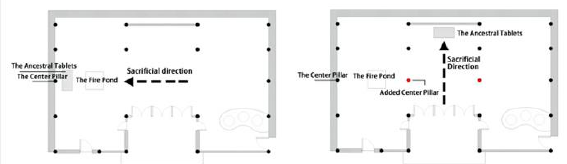
Figure 15. Impact of Changes in Sacrificial Direction on Building Structure.